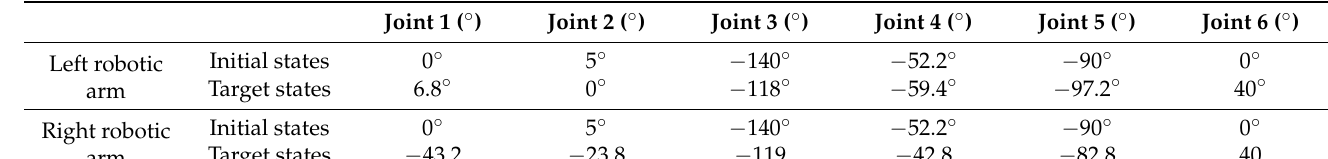
Table 6. Joint information of the robot arm in the collision area.